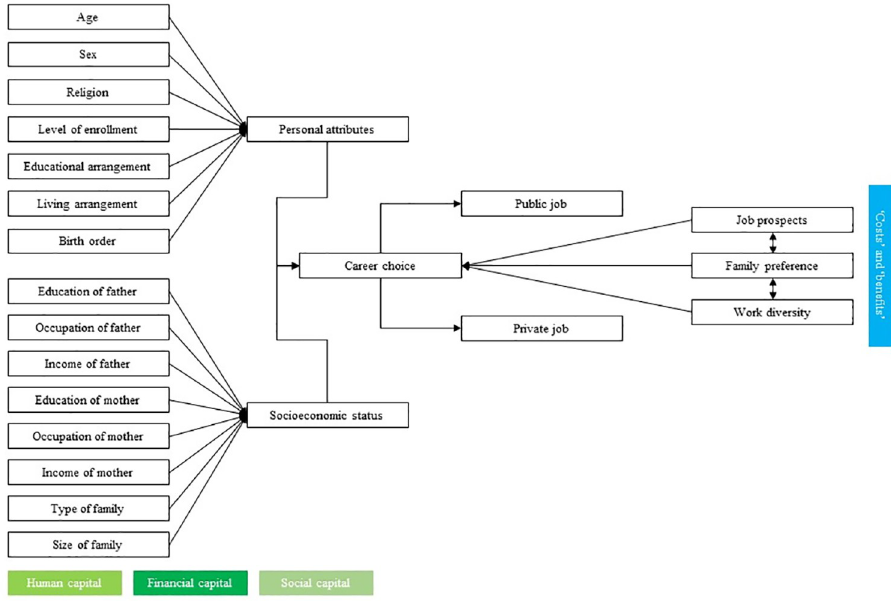
Fig 1. Conceptual framework based on the exchange theory of Homans [24] and the social capital theory of Coleman [25].